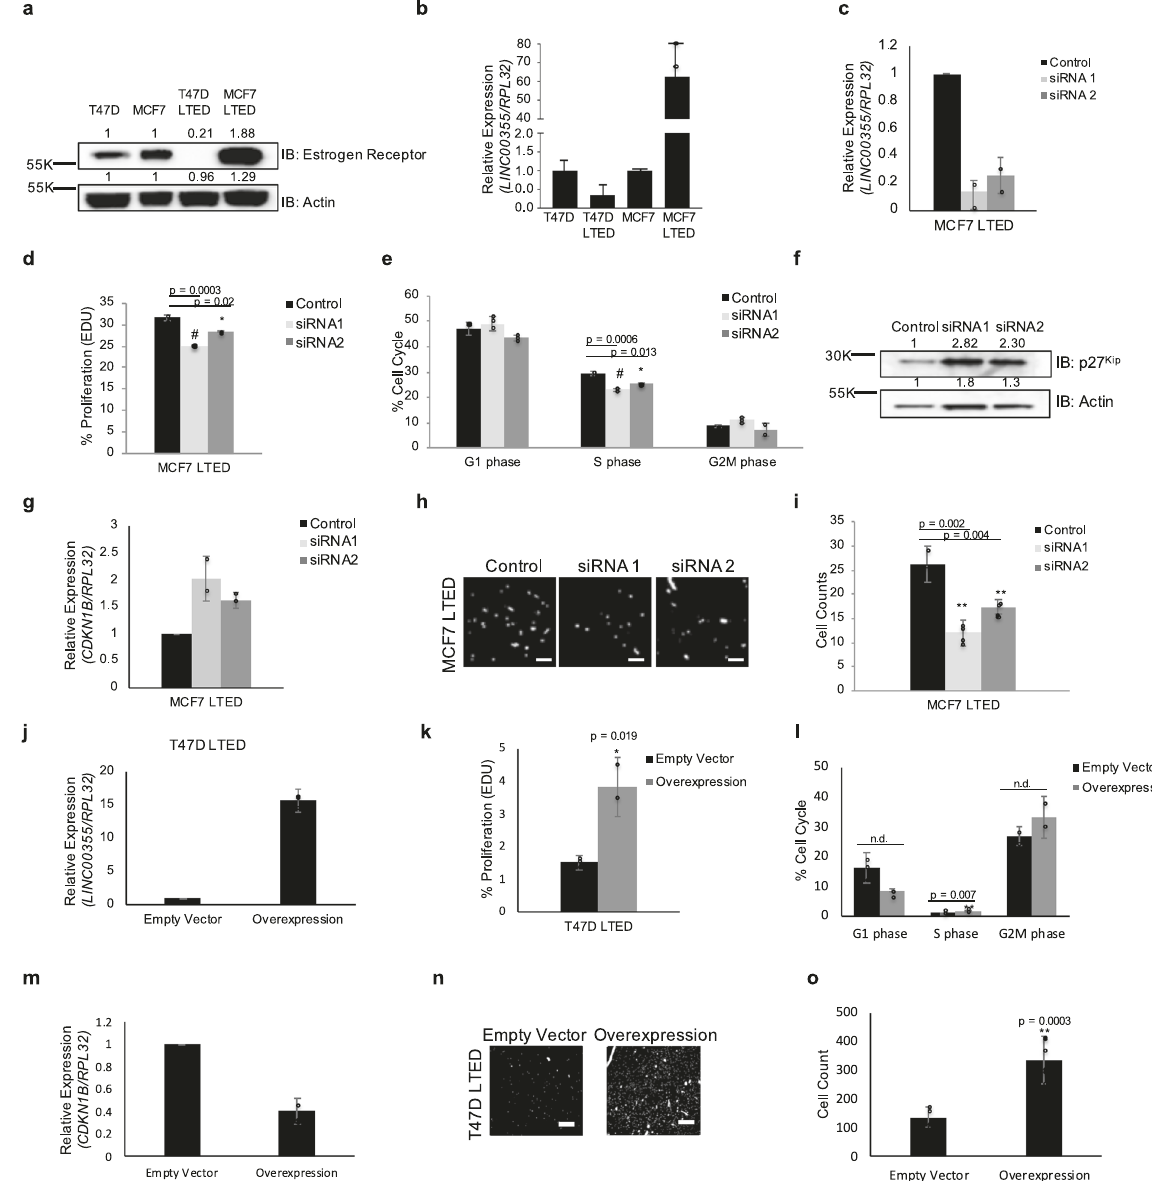
Fig. 4 LINC00355 induces proliferation and invasion in long-term estrogen deprived cell lines. a Expression of Estrogen Receptor in T47D and MCF7 wild-type and long-term estrogen deprived (LTED) cell lines. Fold change normalized to respective wild-type cell lines. b LINC00355 expression in primary and LTED cell lines. c Transient knockdown of LINC00355 in MCF7 LTED cell lines. d and e Decreased LINC00355 expression in MCF7 LTED cells decreased proliferation by EdU and S phase. f Decreased LINC00355 expression increased p27 Kip protein and g CDKN1B mRNA expression. Fold change normalized to control. h and i Cellular invasion decreased with LINC00355 knockdown. j LINC00355 expression inT47D LTED overexpression cell lines. k and l LINC00355 overexpression in T47D LTED cells increased proliferation by EdU and S phase. m LINC00355 overexpression decreased CDKN1B mRNA expression. n and o Cellular invasion increased with LINC00355 overexpression. * p value < 0.05, ** p value < 0.005, # p value < 0.0005, no difference (N.D). Bar = 25 µM. All data are presented as mean values ± s.d, analyzed by two-tailed paired t test, and repeated more than two times. Dapi stained nuclei are shown in white. Source data are provided as a Source Data File.